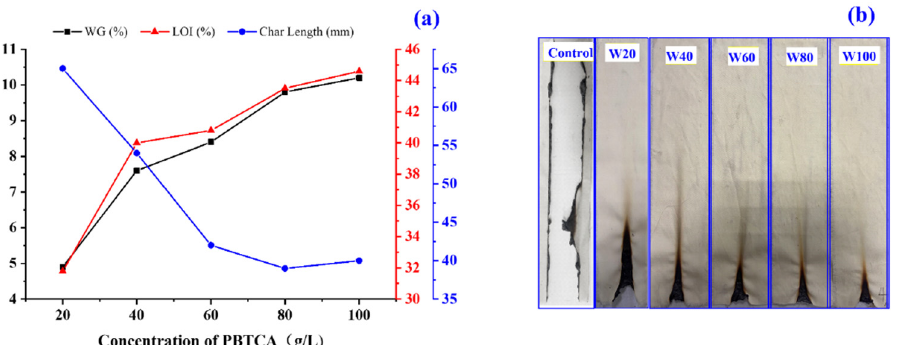
Figure 2. Flame retardancy of the wool fabrics treated with PBTCA ( a ) Weight gain, LOI, and char length of the control and treated wool samples and ( b ) Photos of the wool fabrics treated with different concentrations of PBTCA after VBT